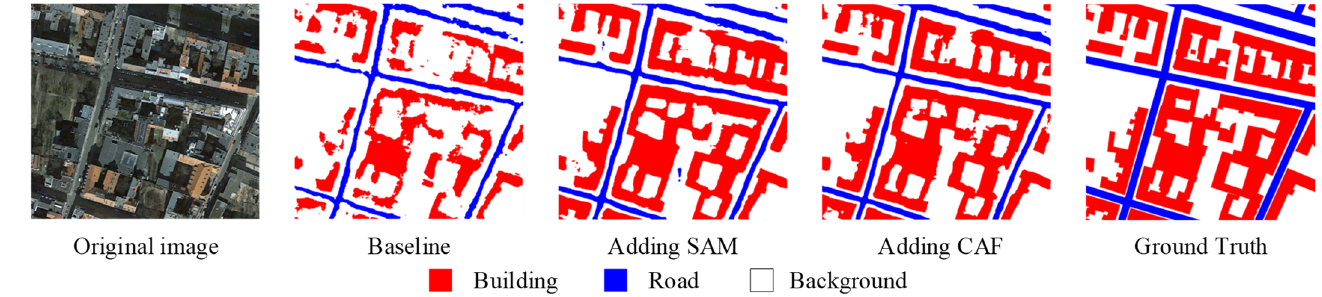
Figure 12. Comparison of visual results of module validity analysis based on CITY-OSM dataset.